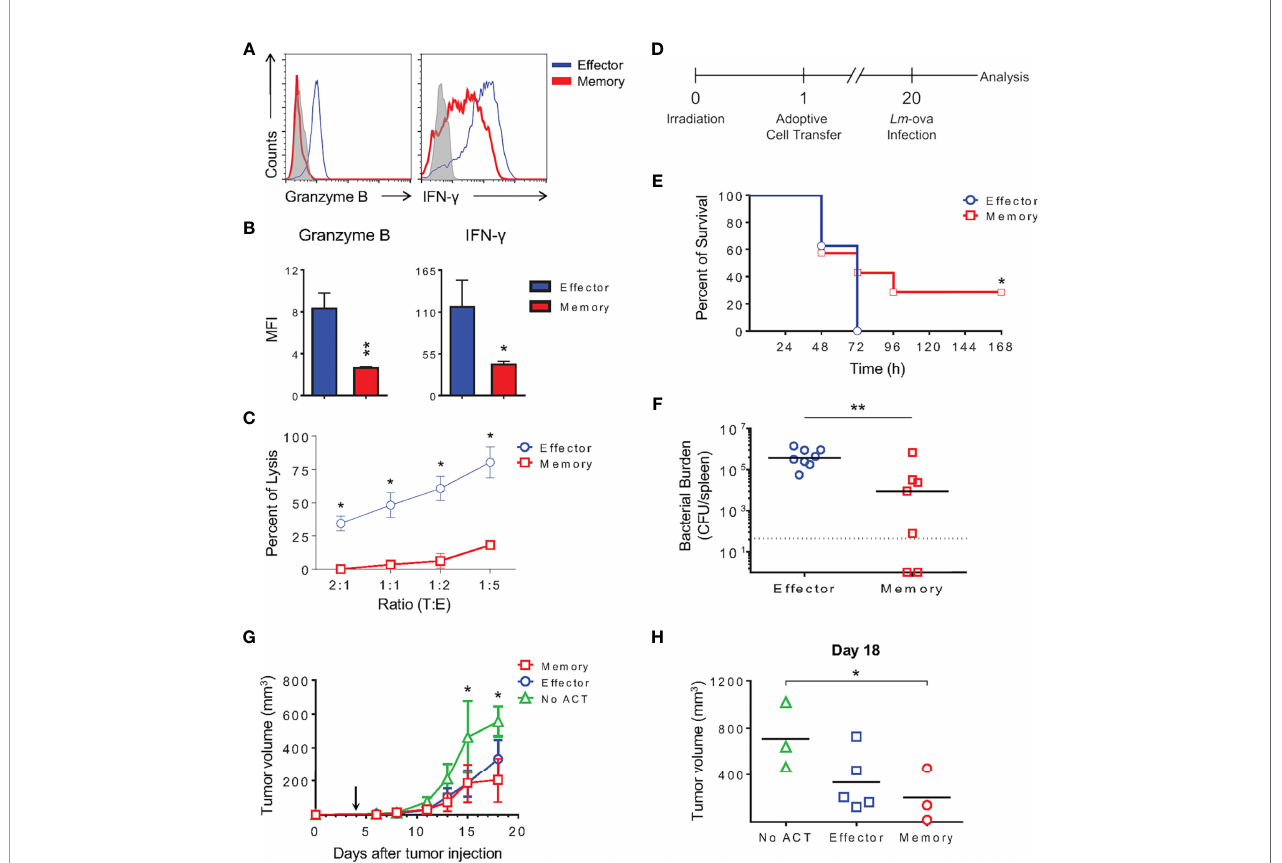
FIGURE 12 | Memory-Like CD8 T Cells Generated In Vitro Are Functional, Promote Long-Term Protection Against Lethal In Vivo Bacterial Challenge In Vitro and Reduce Tumor Progression. (A) Effector and memory lymphocytes were stimulated with PMA and ionomycin for 6 h followed by ICC staining for IFN- g and granzyme B . (B) Bar graphs represent the MFI mean ( ± SD) of IFN- g and granzyme B from in vitro differentiated lymphocytes. (C) Anti-CD3 dependent cytotoxicity assay of effector or memory cells. The results are representative of three independent experiments. (D) Schematic representation of long-term protection experiment involving Listeria monocytogenes producing ovalbumin ( Lm -ova) infection. (E) Survival curve of mice that received 1x10 4 effector or memory OT-I CD8 T lymphocytes generated in vitro 20 days prior to in vivo challenge. The (*) indicates p < 0.05 compared with the effector group. The results are representative of two independent experiments. N= 7 to 8 animals per group. (F) Median of bacterial burden from the spleen of infected recipients. The (**) indicates p < 0.01 compared with the effector group. The results are representative of two independent experiments. N= 7 to 8 animals per group. Effector (blue); memory (red). (G, H) C57Bl/6 mice were inoculated with 0.3 x 10 6 B16-OVA melanoma cells in the right fl ank 4 days prior to transfer of 1.5 x 10 6 in vitro- differentiated effector or memory OT-I T cells intravenously (arrow). Tumors were measured and the volumes calculated as described in the Methods. The (*) indicates p < 0.05 for the difference between tumor size in animals NO ACT and those that received memory OT-I cells. The results are representative of two independent experiments. N = 4 to 5 animals per group. (G) Average of tumor volume for each group of mice that did not receive activated OT-I cells (NO ACT), receiving effector or memory OT-I cells. (H) Analysis of tumor volume 18 days after tumor